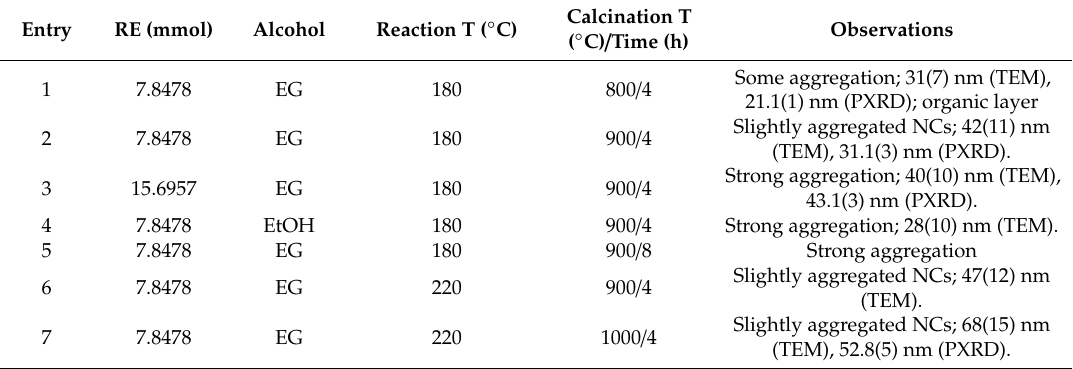
Table 4. Optimization parameters for the synthesis of Y 2 O 3 : Pr 3 + NCs by solvothermal